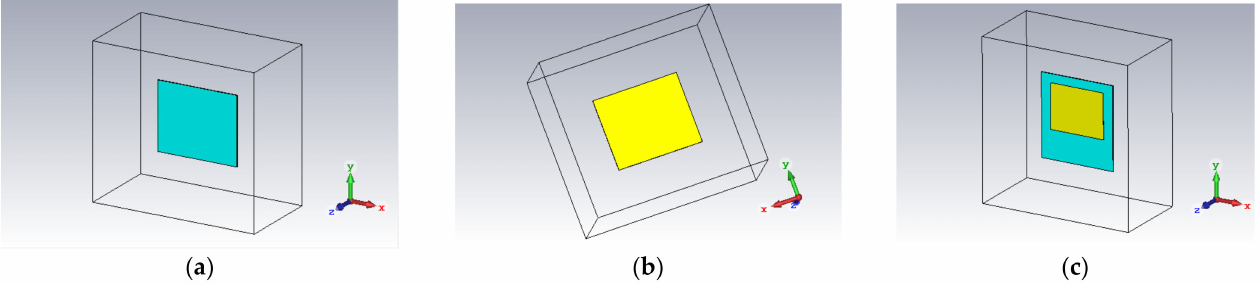
Figure 8. ( a ) Substrate, ( b ) ground, and ( c ) patch antenna.